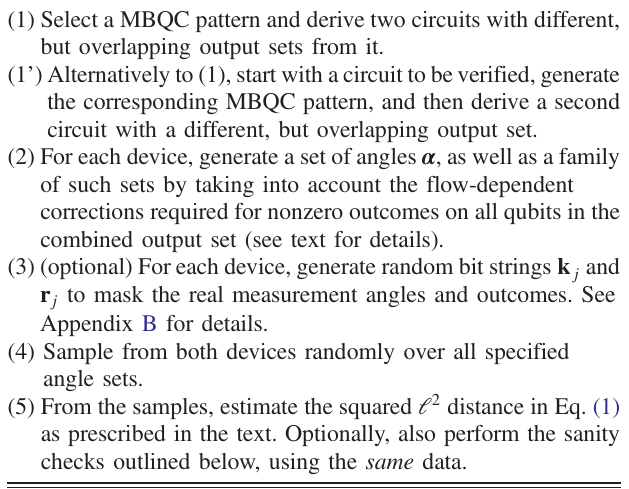
Algorithm 1. Cross-check